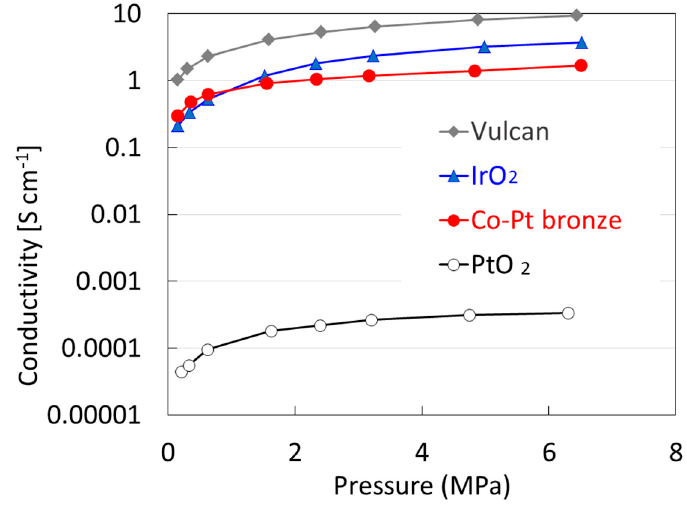
Figure 4. Electronic conductivities of Vulcan (carbon black), IrO 2 (Furuya), Co-Pt bronze and PtO 2 measured by a compression cell.